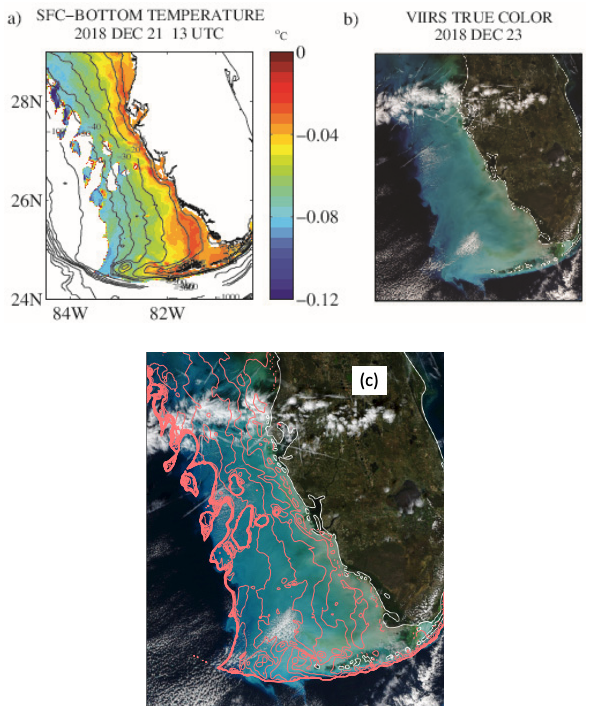
Figure 9. ( a ) COAMPS temperature inversion on 21 December 1300 UTC is the beginning of the solar period, and the temperature inversion remains consistent during the day; ( b ) TOA True Color VIIRS (NOAA-20) 23 December 2018; and ( c ) the direct overlay of ( a ) upon ( b ) showing the spatial match-up between the color discontinuity and the temperature